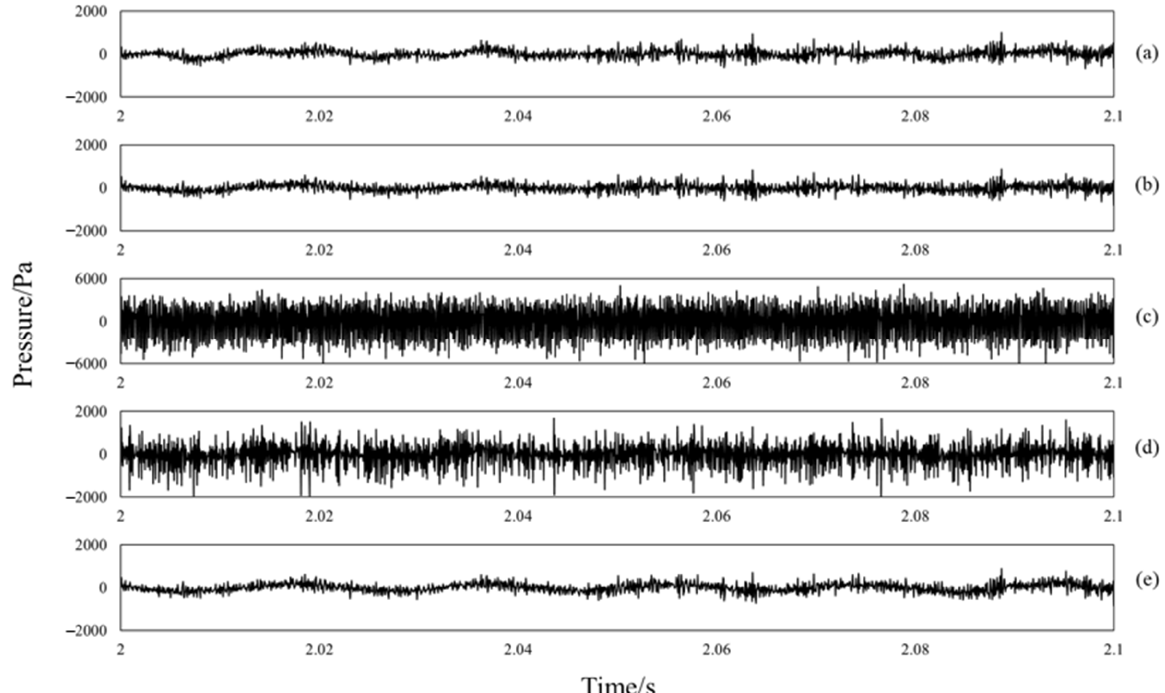
Figure 13. The fluctuation of pressure over time at the velocity of 12 kn. ( a ) Re s = 2.689 × 10 5 . ( b ) Re s = 6.738 × 10 5 . ( c ) Re s = 1.011 × 10 6 . ( d ) Re s = 1.482 × 10 6 . ( e ) Re s = 2.561 × 10 6 .